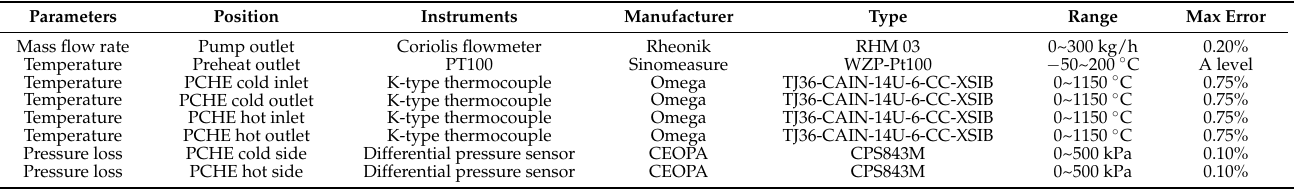
Table 2. The direct measuring instruments and